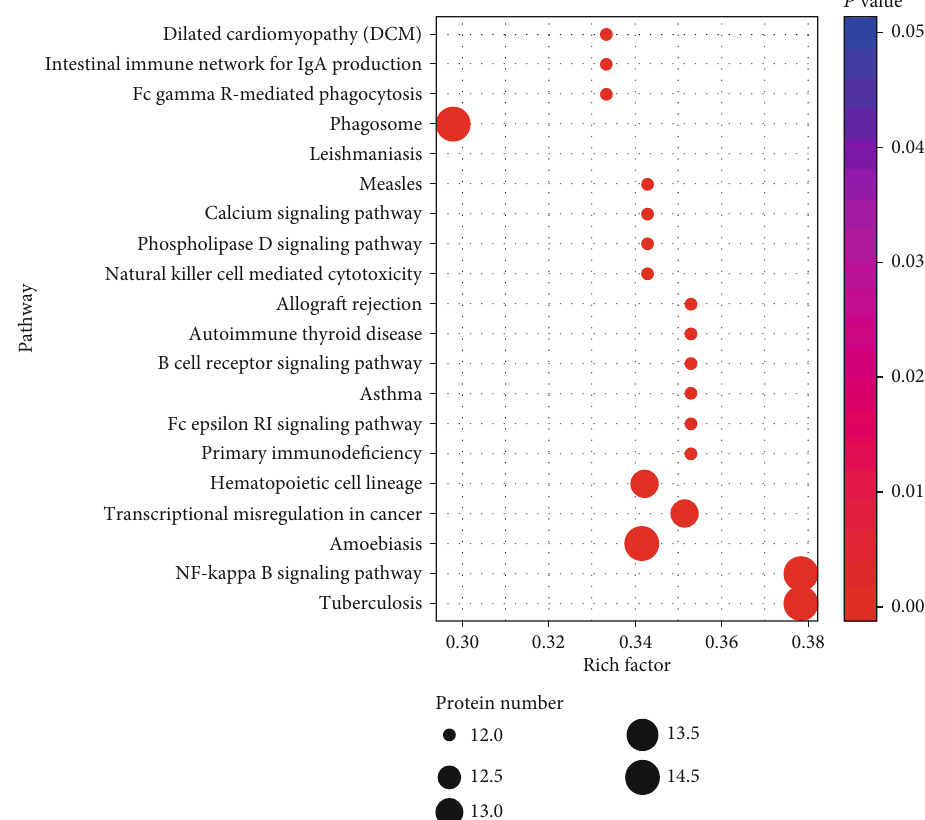
Figure 5: Integrated analysis based on metabolic pathways enrichment of di ff erentially expressed proteins in rheumatoid arthritis patients compared with normal controls. ∗ Rich factor: di ff erentially expressed proteins annotated to pathway/all identi fi ed proteins annotated to pathway. The dot size represents the number of di ff erentially expressed proteins annotated to